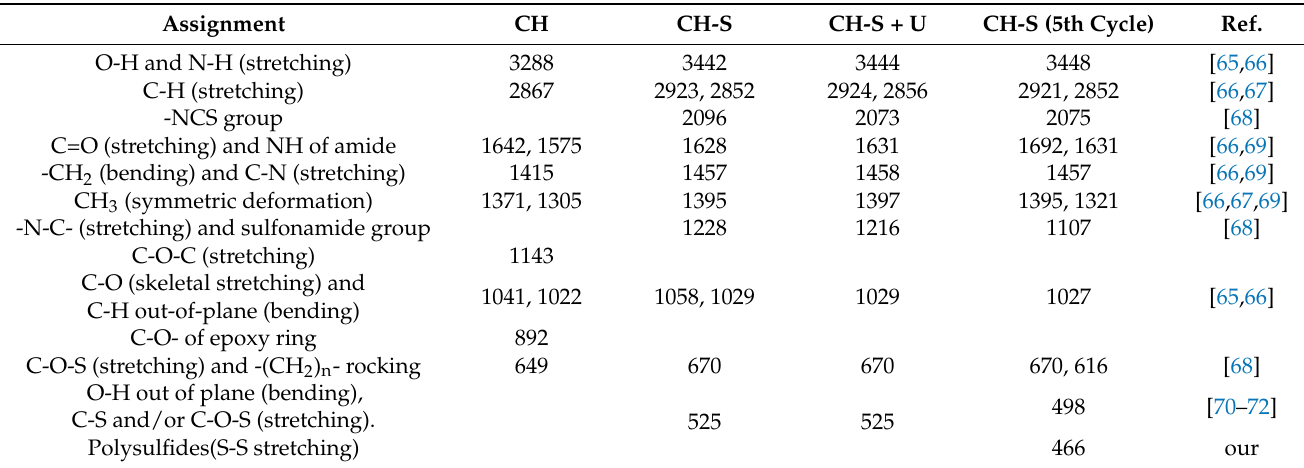
Table 2. Assignments peaks in FTIR spectra for CH and CH ‐ S (before and after U(VI) sorption, and after five cycles of sorption and desorption).